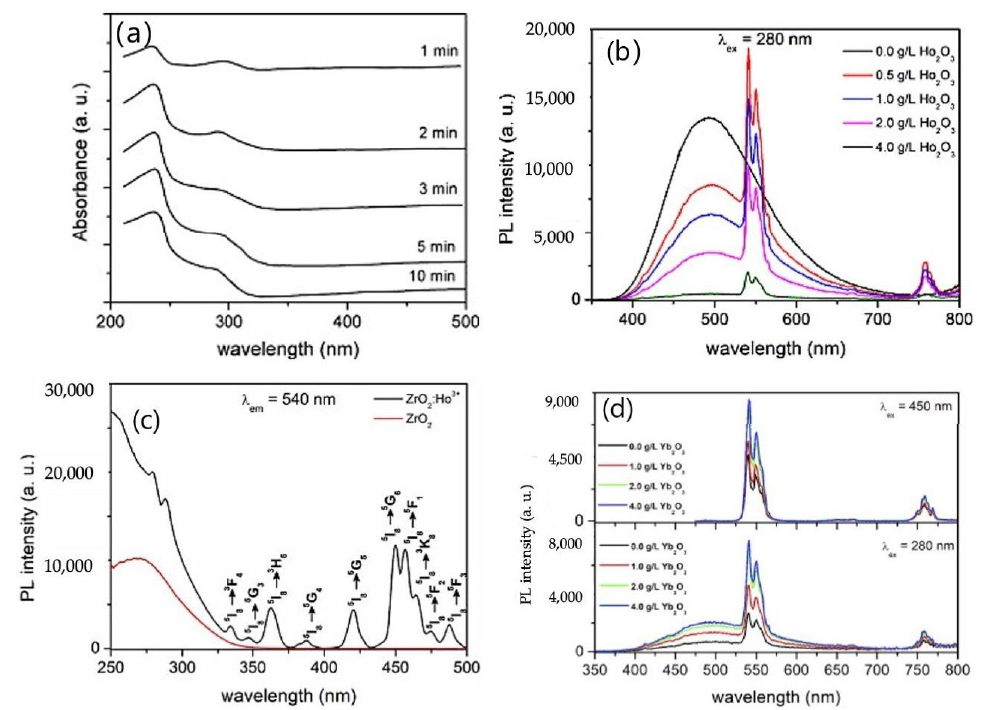
Figure 7. ( a ) Alteration of diffuse reflection spectra of zirconia films based on treatment time of the PEO process [82] (Reproduced with permission number: 5043541253698, Elsevier); ( b ) photolumi- nescence emission spectra excited with 280 nm radiation of PEO coating produced in phosphate electrolyte with addition of Ho 2 O 3 powder in different concentrations for a treatment time of 10 min [78]; ( c ) photoluminescence excitation spectra of undoped and Ho-doped ZrO 2 coatings produced by PEO for a treatment time of 10 min in phosphate electrolyte with and without 0.5 g/L Ho 2 O 3 addition [78]; ( d ) photoluminescence emission spectra excited with 280 and 450 nm radiation of PEO coatings produced in phosphate electrolyte with addition of 4.0 g/L Ho 2 O 3 particles and Yb 2 O 3 particles in different concentrations for a treatment time of 10 min [78] (Reproduced with permission number: 5043550012051, Elsevier).